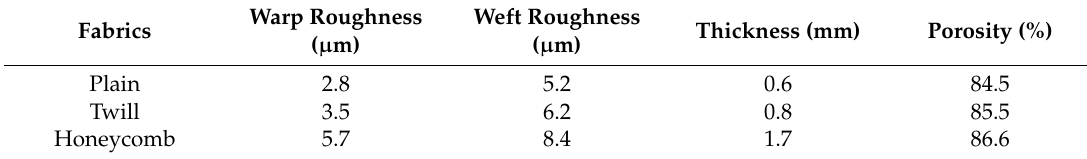
Figure 1. Three types of woven fabrics shown on the weaving paper ( a ), three-dimensional ( b ), and fabric photographs ( c ). Table 1. Roughness, thickness and porosity of fabrics with different structures.